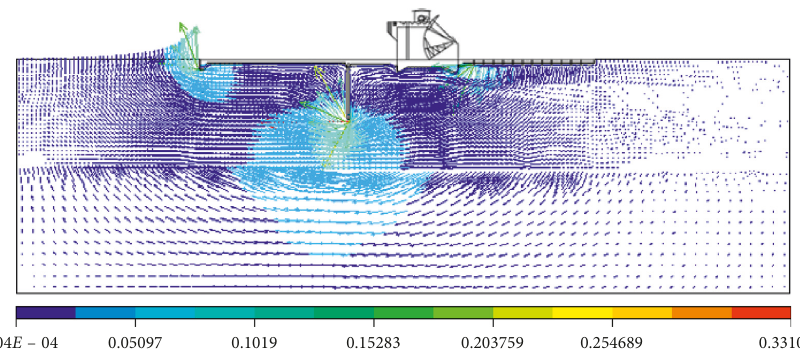
Figure 27: Seepage gradients in 2# sluice foundation in dry